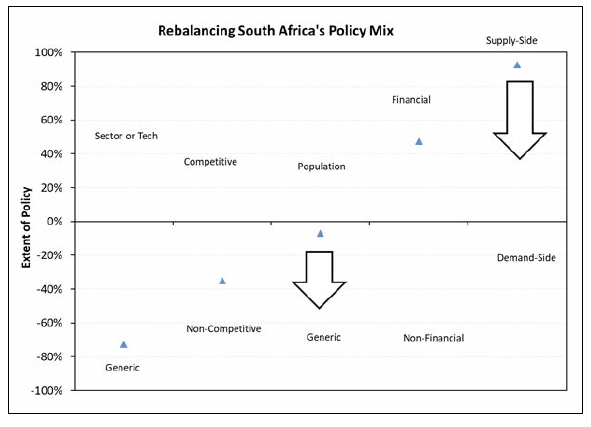
figure 4: Recommended adjustments to South Africa’s innovation policy mix.